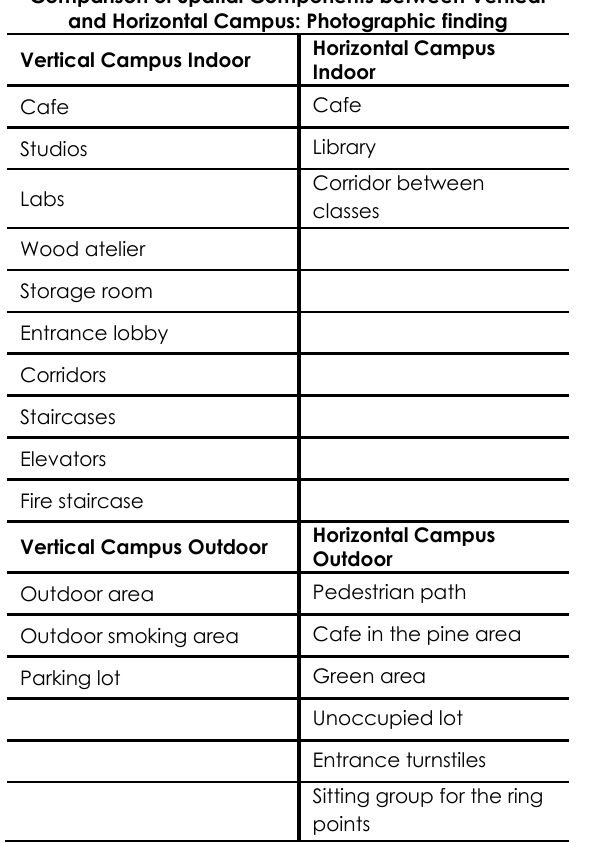
Table 9: Comparison of Spatial Components between Vertical and Horizontal Campus. Comparison of Spatial Components between Vertical and Horizontal Campus: Photographic